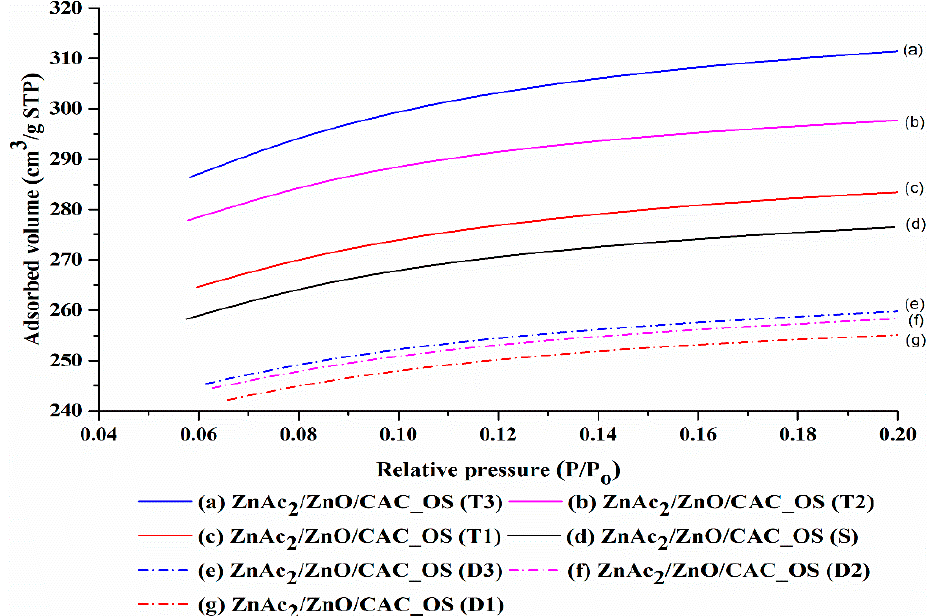
Figure 5. N 2 adsorption–desorption isotherms of ZnAc 2 /ZnO/CAC_OS adsorbents through three H 2 S adsorption–desorption cycles.